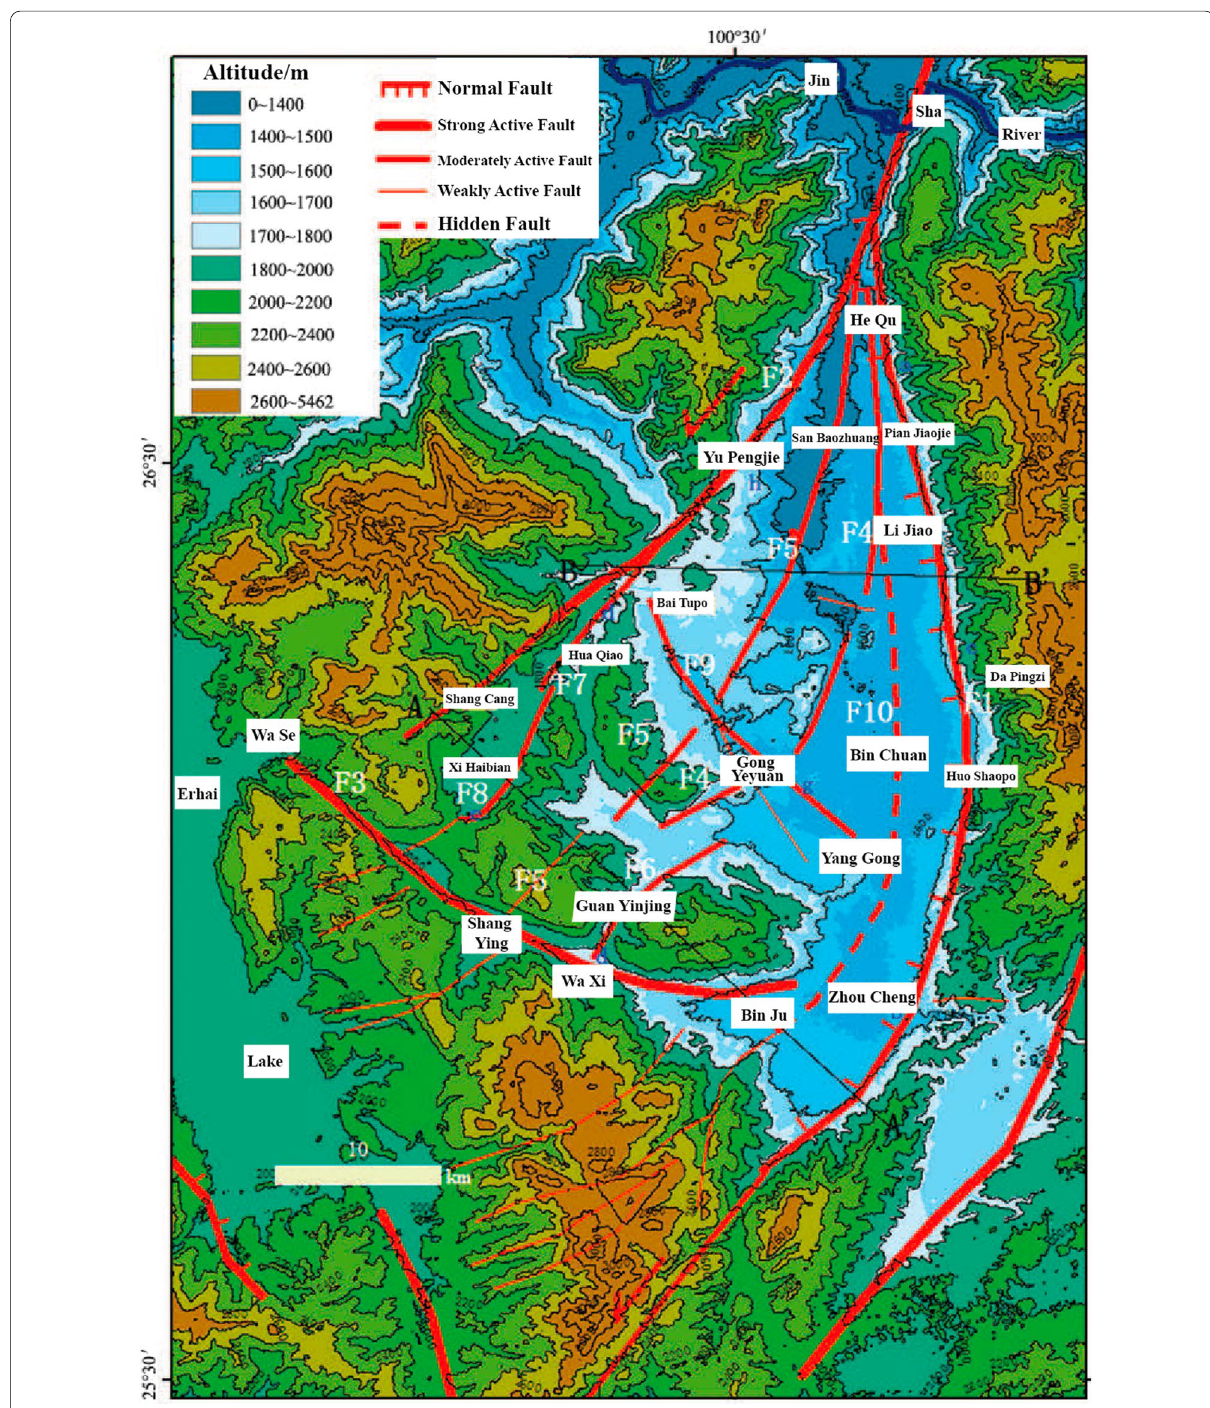
Fig. 13 Topographic map of the Binchuan area (Luo et al. 2015). F1–F9 represent Binchuan Fault, Shangcang-Yupeng Fault, Binju Fault, Pianjiao-Daying Fault, Hequ-Shangying Fault, Zhouchengxi Fault, Huaqiao Fault, Xihaibian Fault, and Baitupo-Yanggongcun Fault, respectively. F10 indicates a hidden